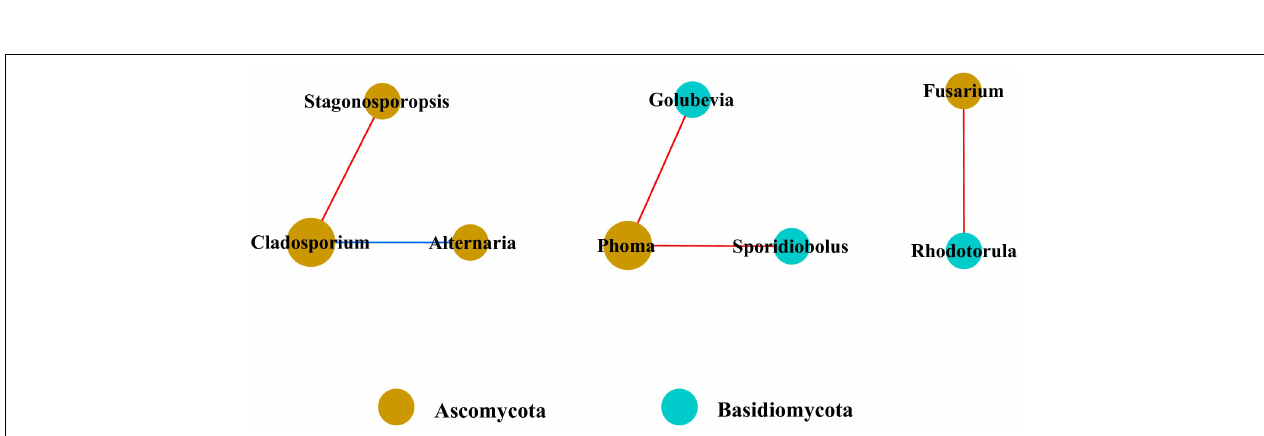
FIGURE 6 | Co-occurrence network of bacteria at genera level. Only p values less than 0.05 and corrections coefficients higher than 0.6 were constructed in the network. The size of each node is proportional to the number of connections, the color of each node is correlates with taxonomy. Blue edges indicate positive correlations, and red edges indicate negative correlations.